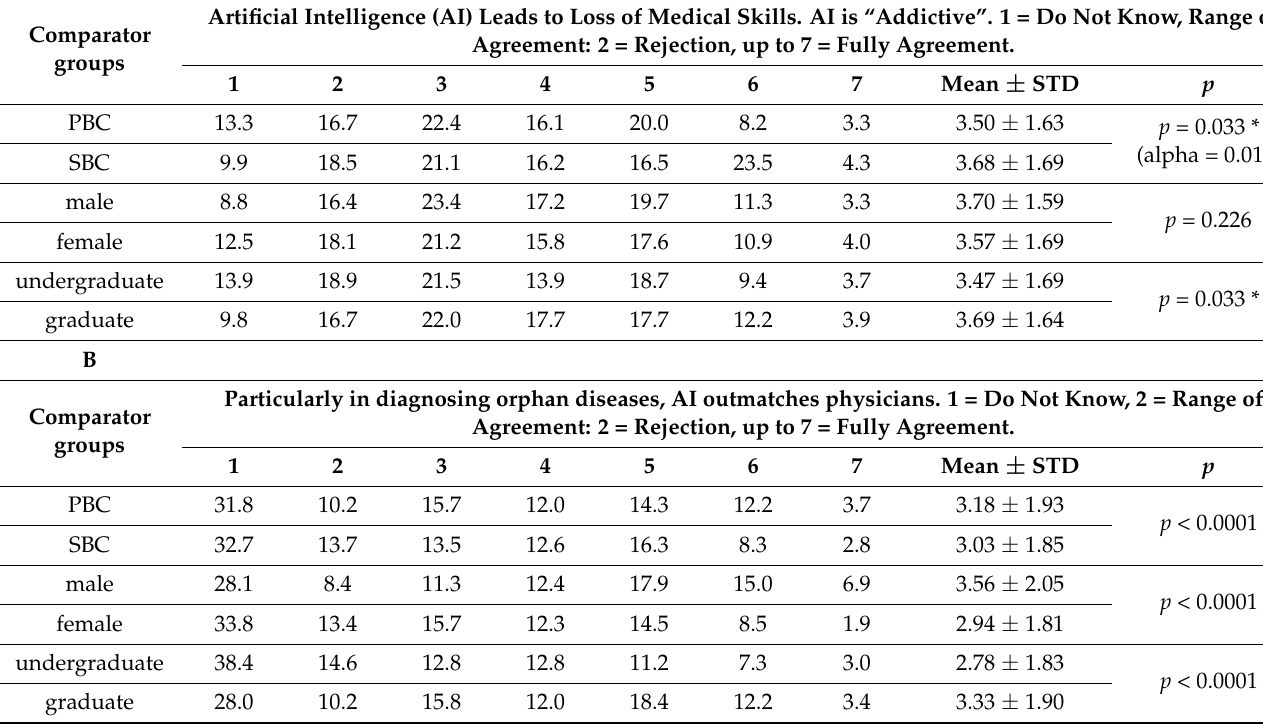
Table 5. ( A – C ) Response (% in numeric columns) to given questions. Statistical group